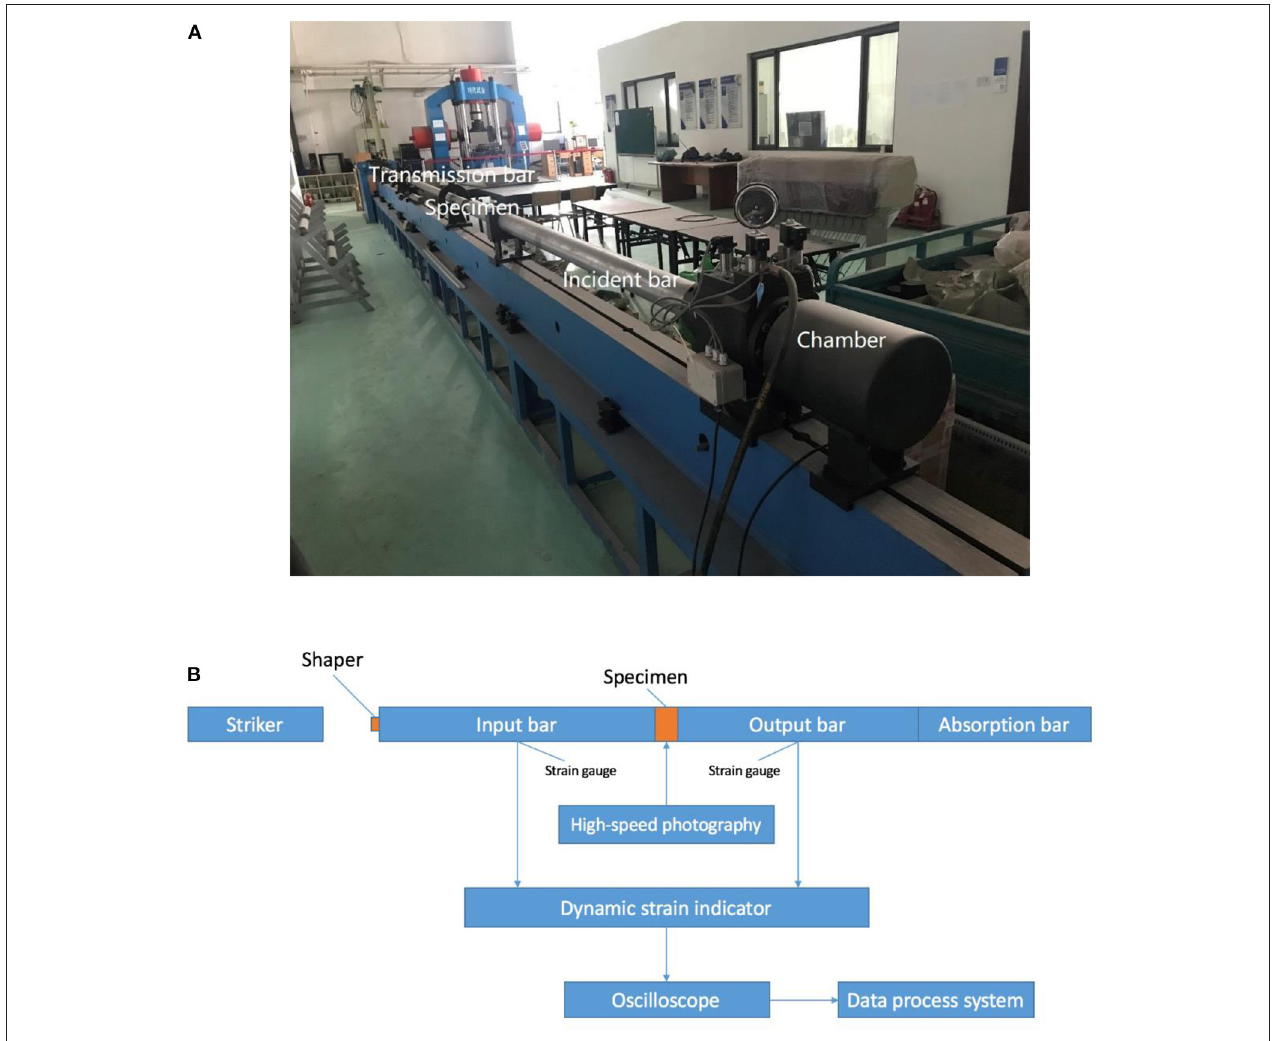
FIGURE 2 | SHPB test system (A) photograph (B) schematic illustration.